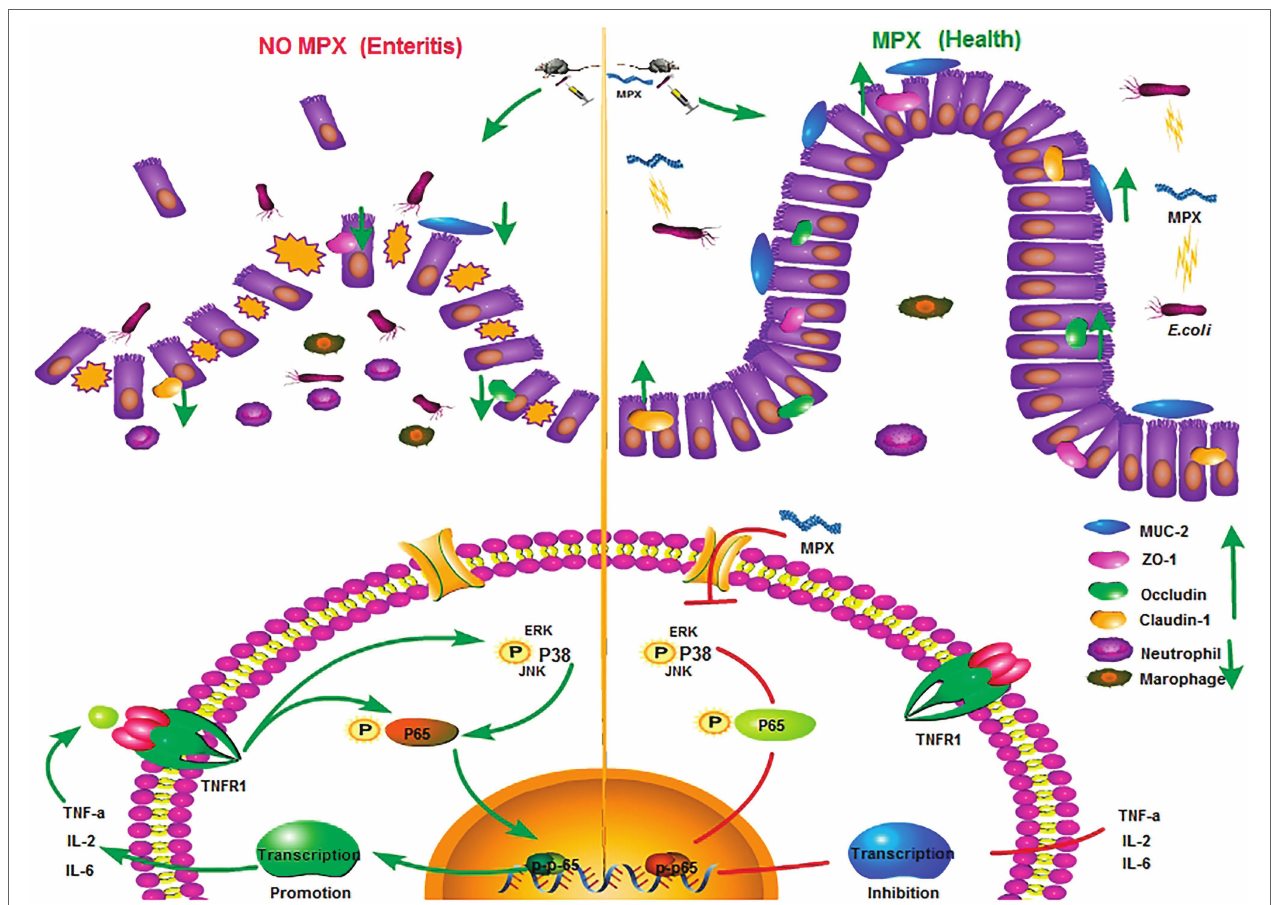
FIGURE 8 | MPX regulates epithelial cells and in vivo signaling